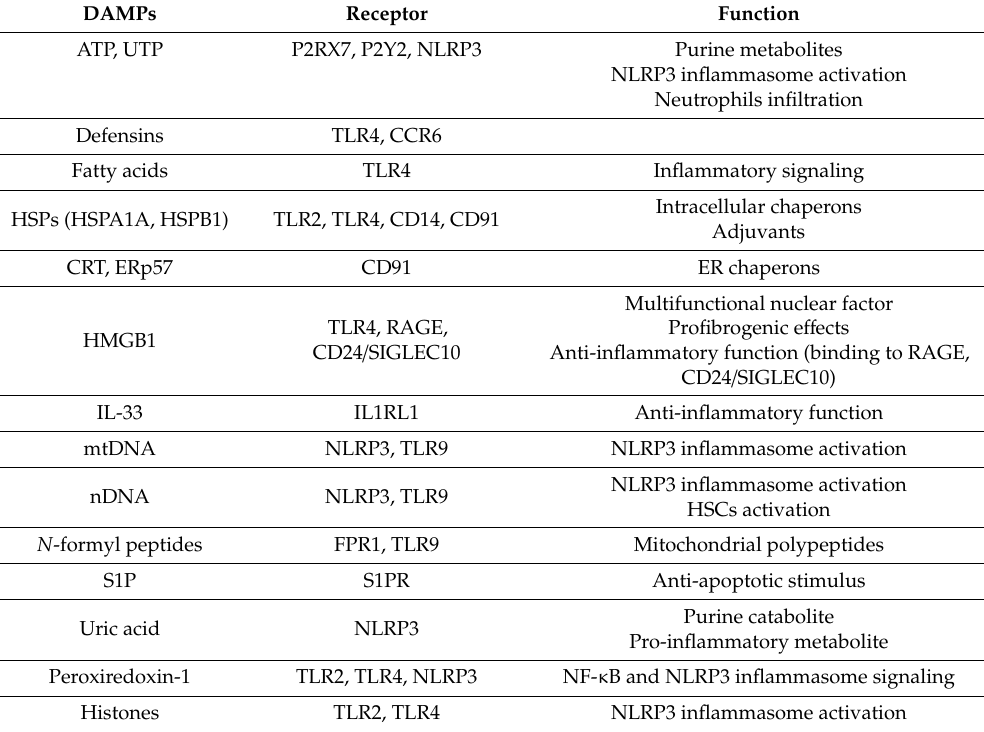
Table 1. List of DAMPs, receptors and their function in liver